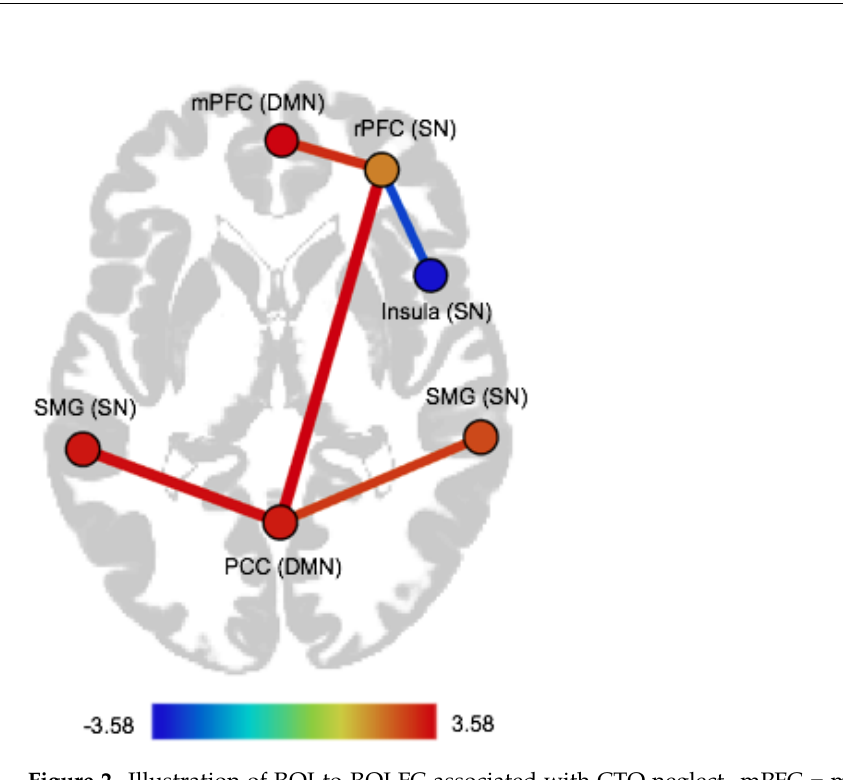
ROI = region of interest, Dir = Direction, FC = Functional connectivity, rPFC = rostral prefrontal cortex, PCC = precuneus cortex, mPFC = medial prefrontal cortex, SMG = supramarginal gyrus, pos = positive, neg = negative, FDR = false discovery rate.